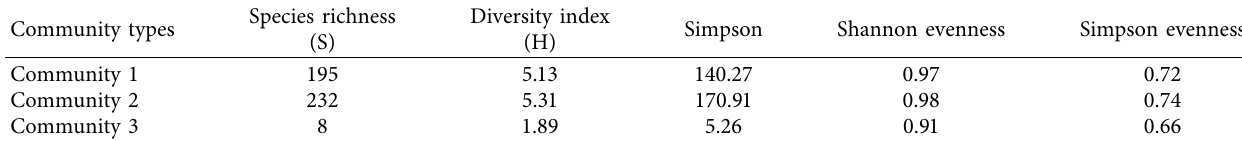
Figure 4: Dendrogram showing the plant community types of Table 2: Species richness, evenness, and Shannon–Wiener diversity index of the plant community types. Community types